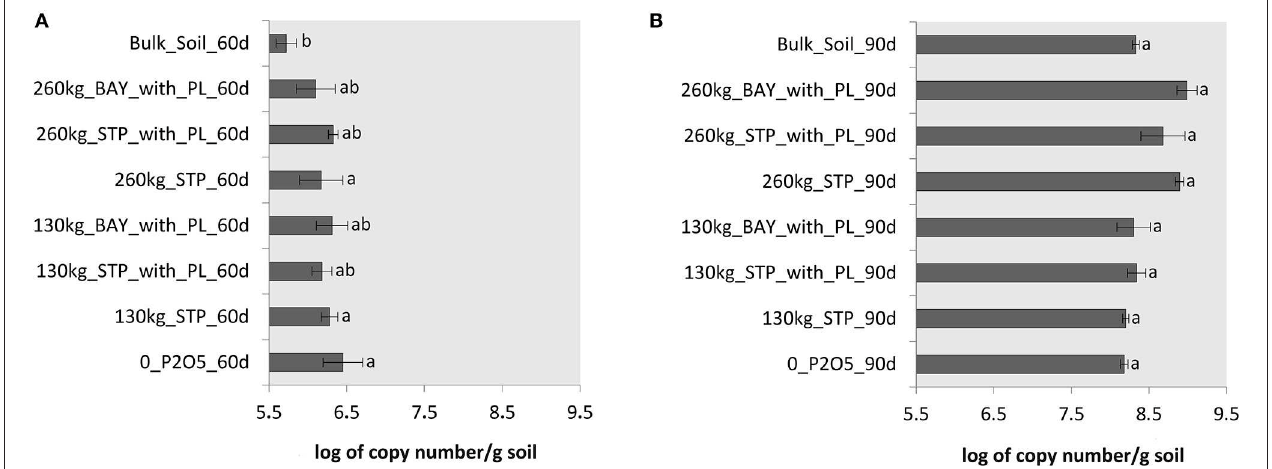
FIGURE 4 | Abundances of phosphate-mineralizing bacteria ( phoD gene). (A) Samples taken 60 days after sowing, and (B) Samples taken 90 days after sowing maize. Treatments (in A or B ) that do not share a letter have a mean difference that is statistically significant based on Tukey’s pairwise test ( p <